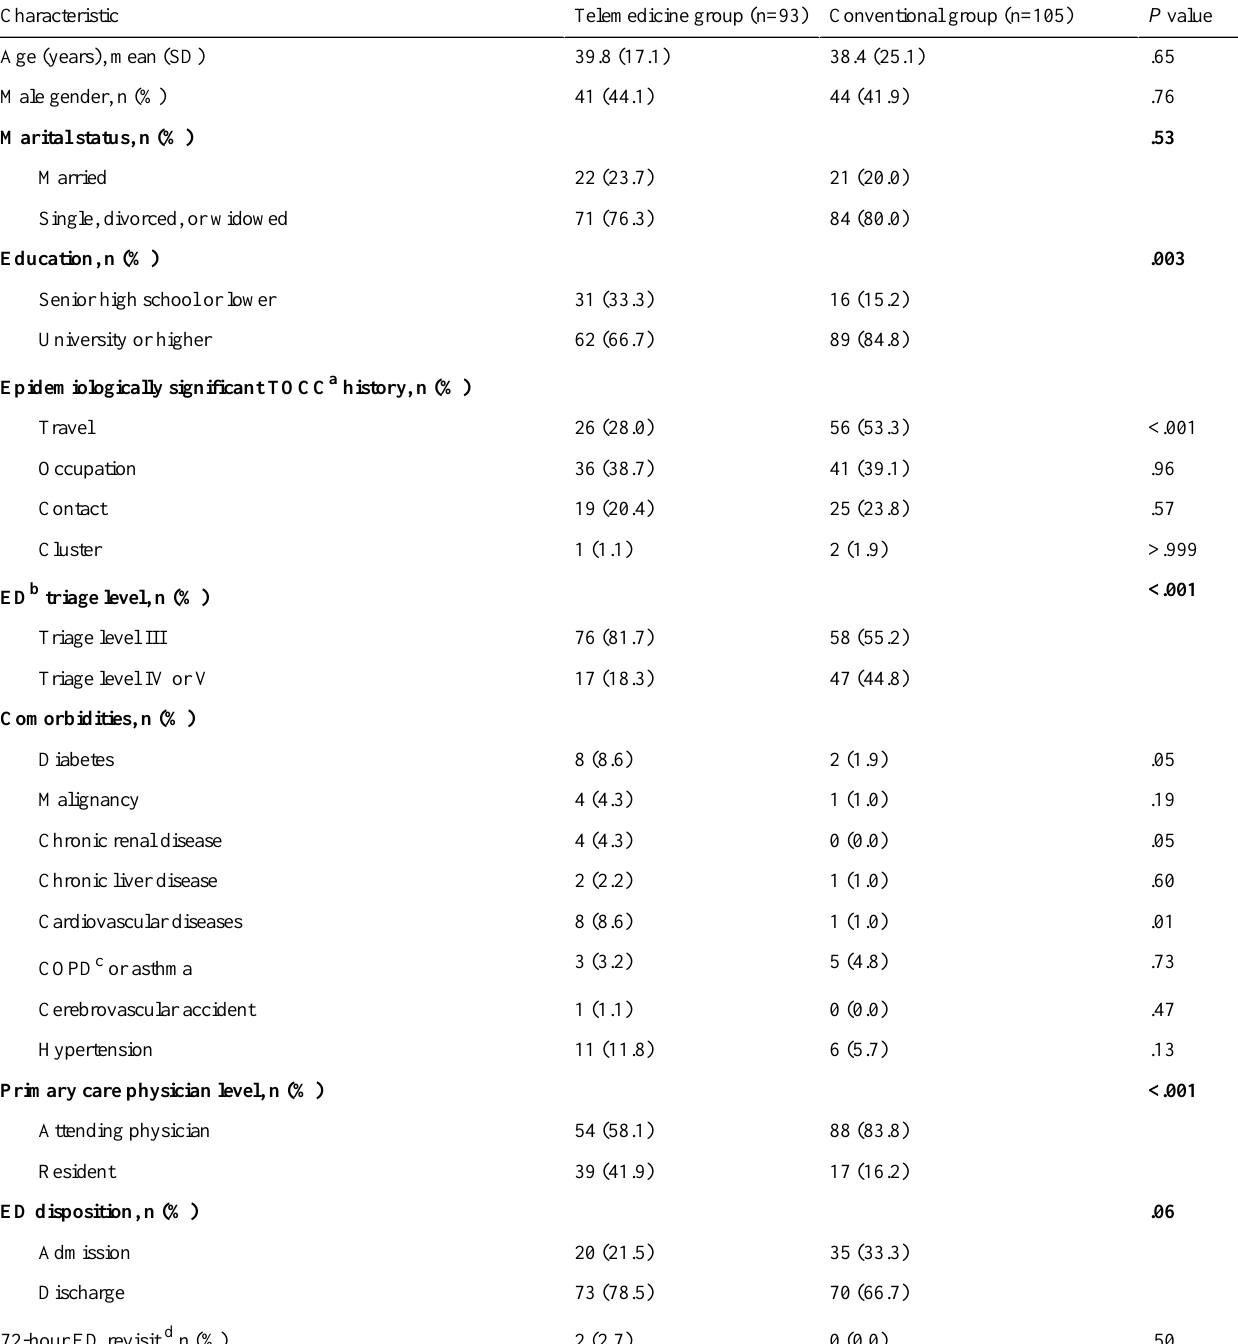
Table 1. Baseline demographic and clinical characteristics of patients in the telemedicine and conventional groups (N=198).